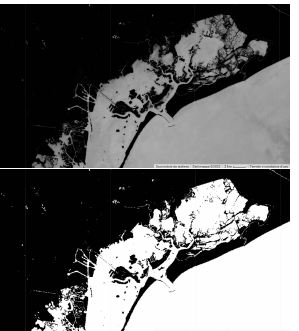
Figure 3. Comparison between NDWI (above) and AWEI (below) resulting images on the same area (Venice lagoon).